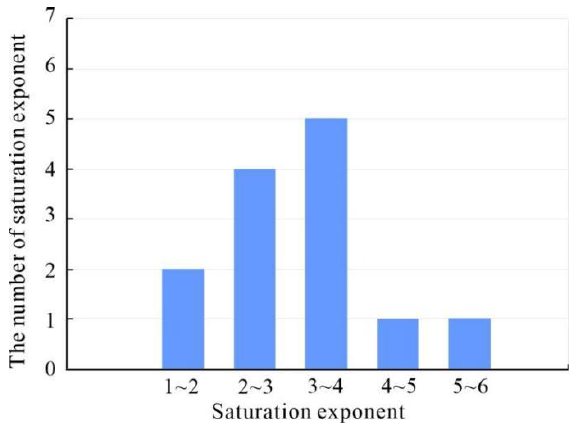
Figure 7. The distribution of the saturation exponent (n). The x -axis indicates the range of saturation exponent values. The y -axis represents the number of saturation exponents in a certain range of saturation exponent values. In Section 3.2 of this study, the average coordination number fails to represent pore water connectivity. Therefore, we extracted connected pore water from three-dimensional